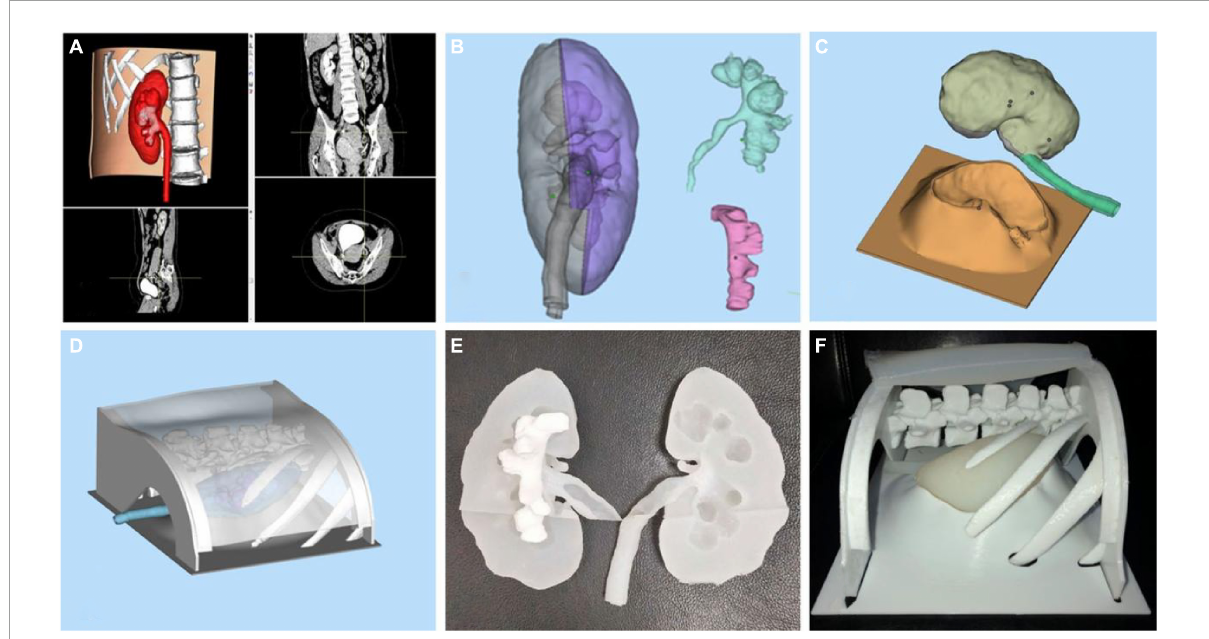
FIGURE5 The 3D-printed model of kidney stones. Panel (A) is the software modeling. Panels (B–D) are the model constructions before printing. Panels (E,F) are 3D printed models of kidney related structures and stones